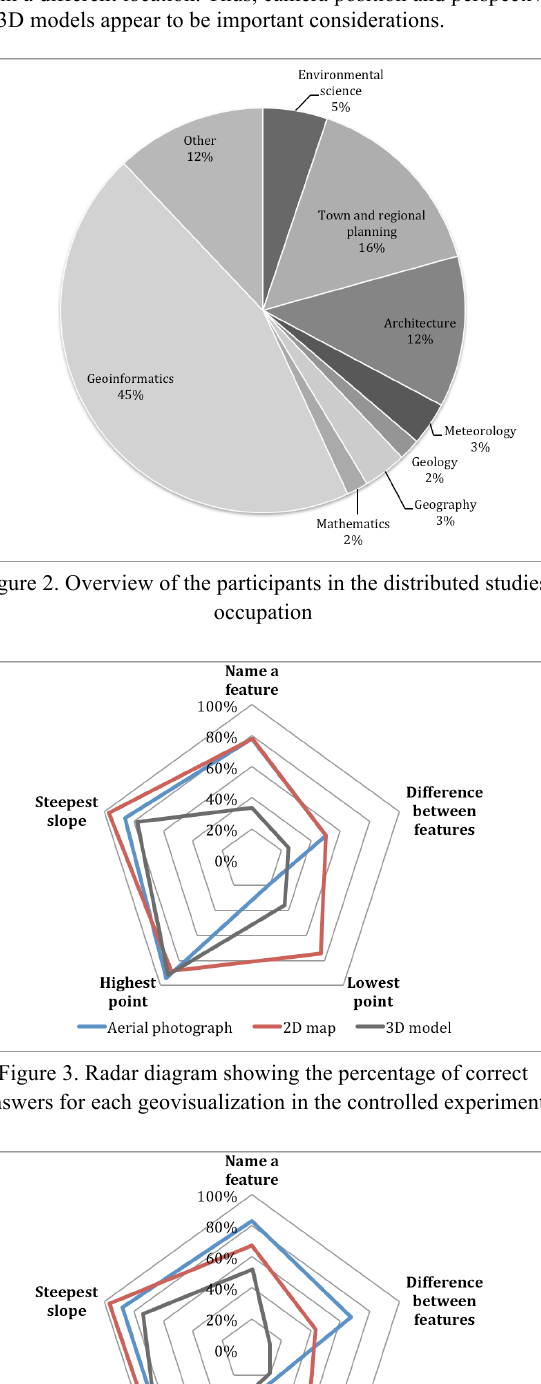
Figure 4. Radar diagram showing the percentage of correct